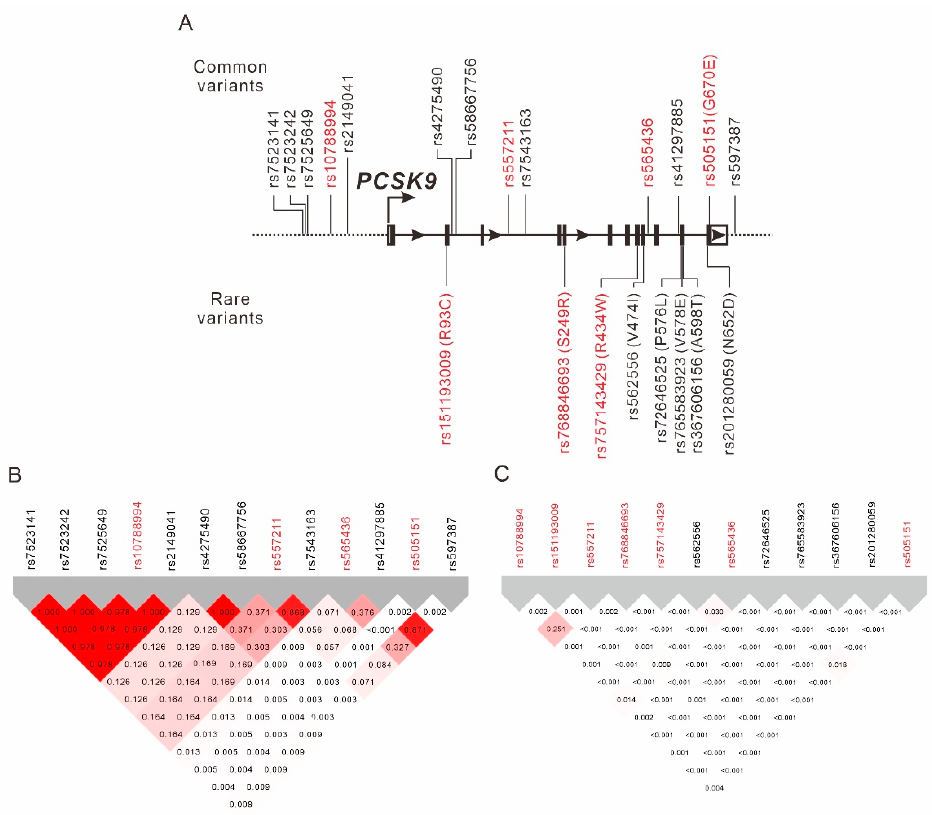
Figure 3. Location ( A ) and linkage disequilibrium ( B , C ) of common and rare PCSK9 variants. Shades of red and gray show the strength of the pairwise linkage disequilibrium based on r 2 , and numbers indicate the value of r 2 . Seven PCSK9 variants associated with LDL-C levels for weighted genetic risk scores are highlighted in red font.